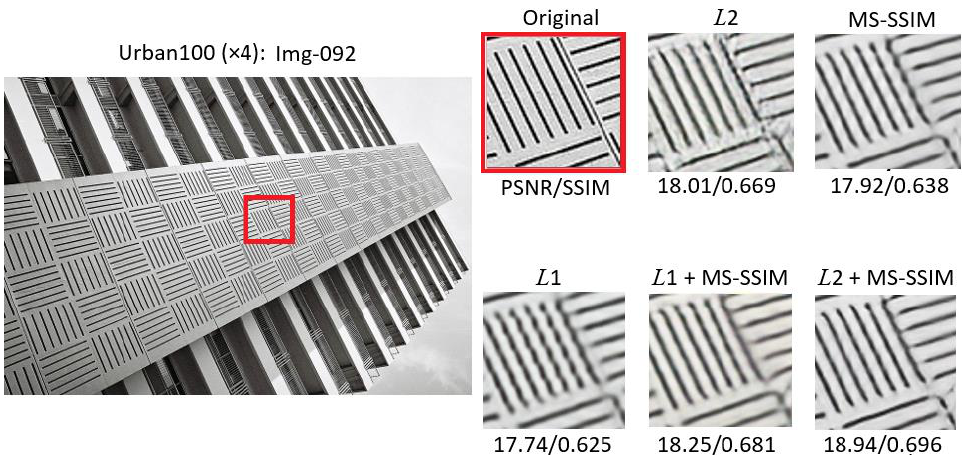
Figure 10. Visual comparison of different objective functions on Img-092 image from the Urban100 dataset at × 4 scale.